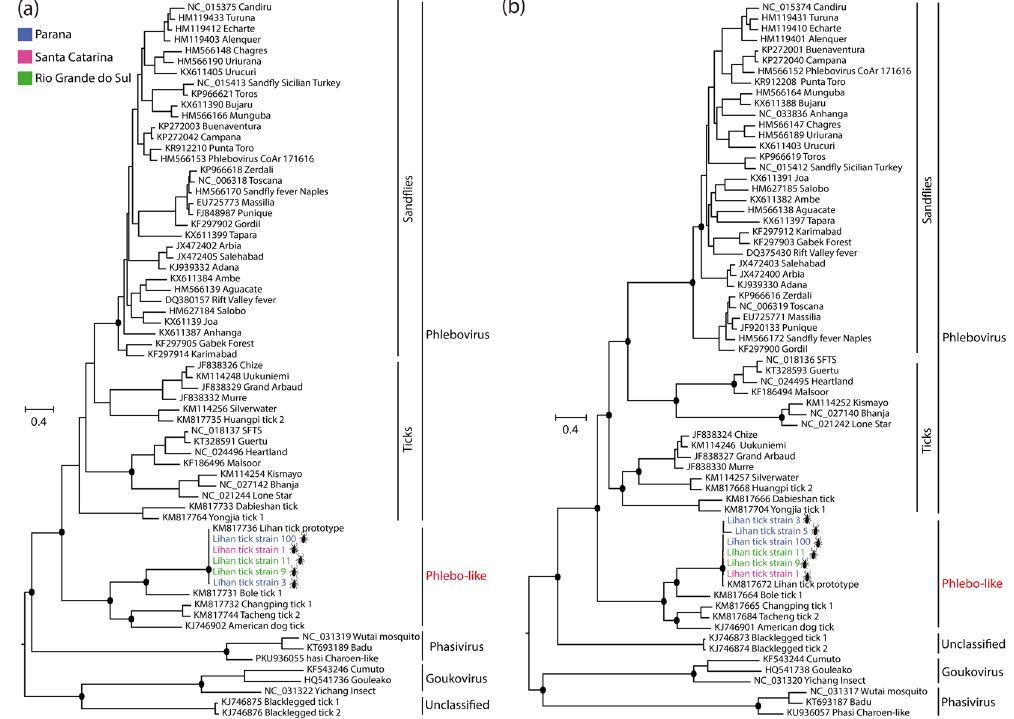
Figure 2. Maximum likelihood phylogenies of new strains of Lihan tick virus into Phenuiviridae family. Phylogenies were constructed on amino acids alignments sequences of nucleoprotein ( a ) and RNA-dependent RNA polymerase ( b ) based on LG + I + G4 amino acids substitution model. Phylogenies are midpoint rooted for clarity of presentation. The scale bar indicates evolutionary distance in numbers of substitutions per amino acids sites. Taxons are colored according to geographical location, and the host was denoted with a silhouette. The legends for the colors are shown on the left. The black circles indicate the main nodes with maximum likelihood bootstrap support levels above 75% bootstrap